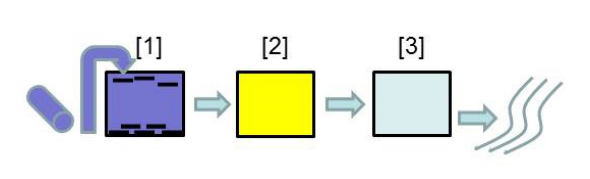
Fig. 1. Process steps of sewage